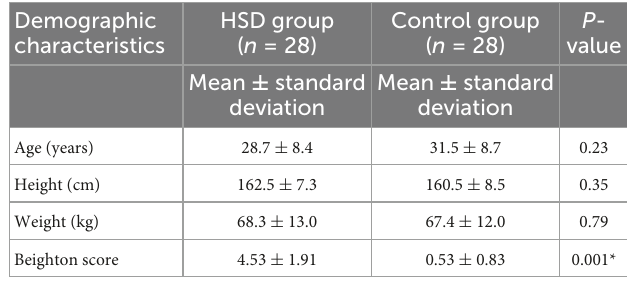
TABLE 1 The demographic characteristics of the hypermobility spectrum disorders (HSD) group compared to the control